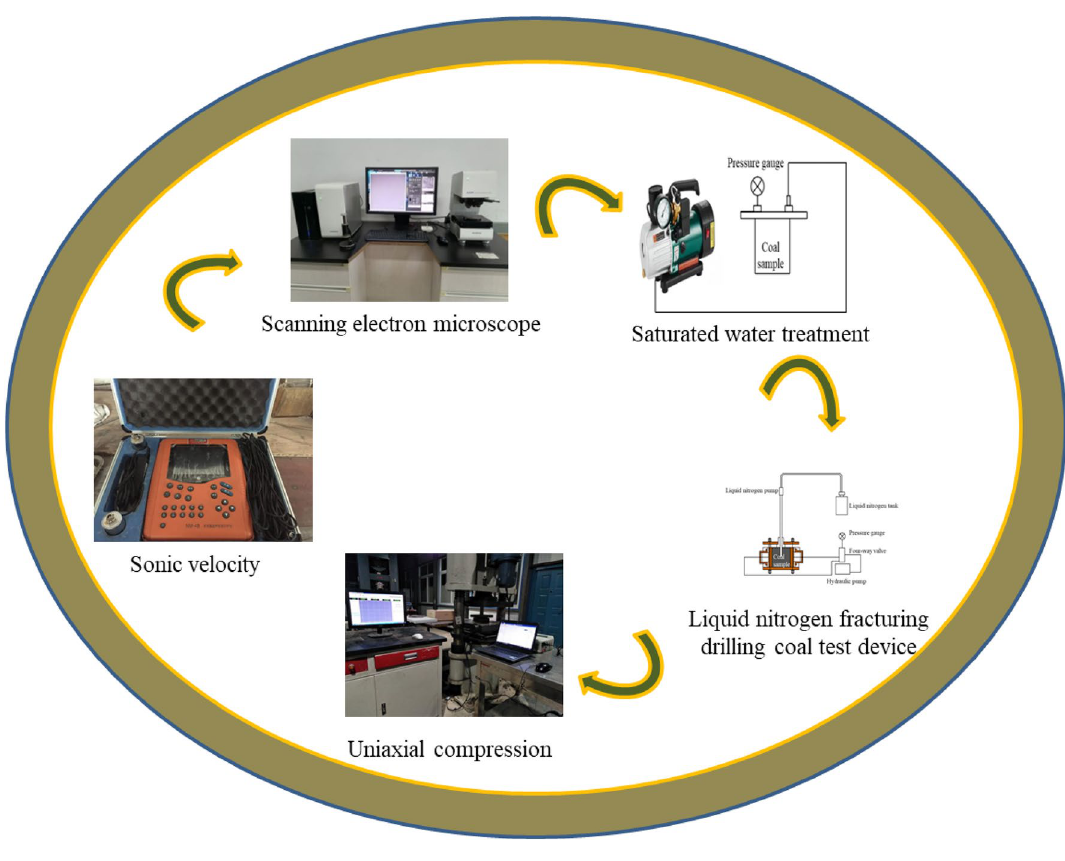
Figure 1. Test flow